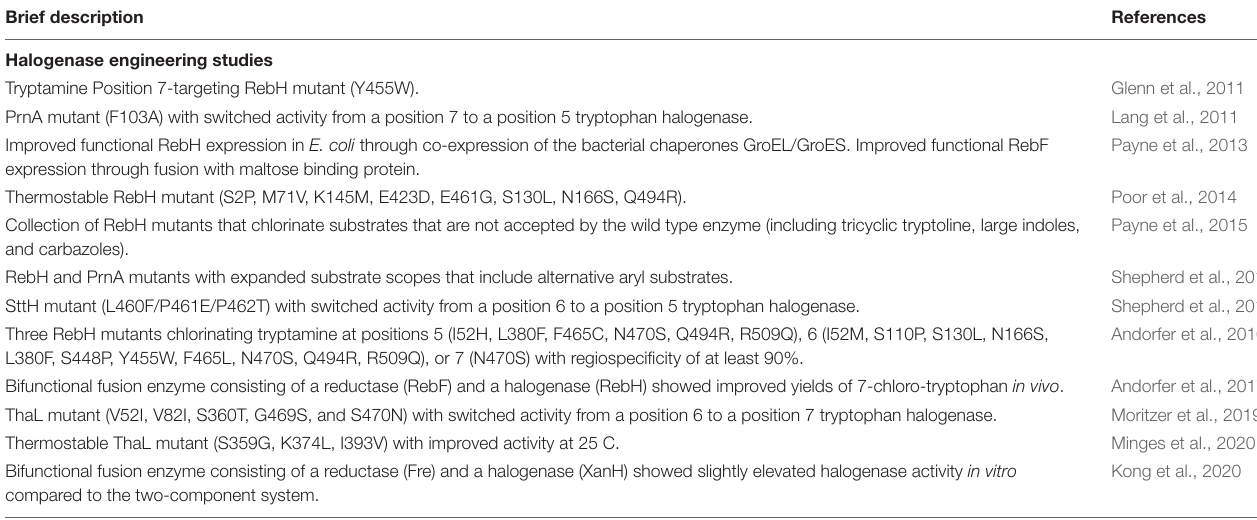
TABLE 3 | Engineered Tryptophan